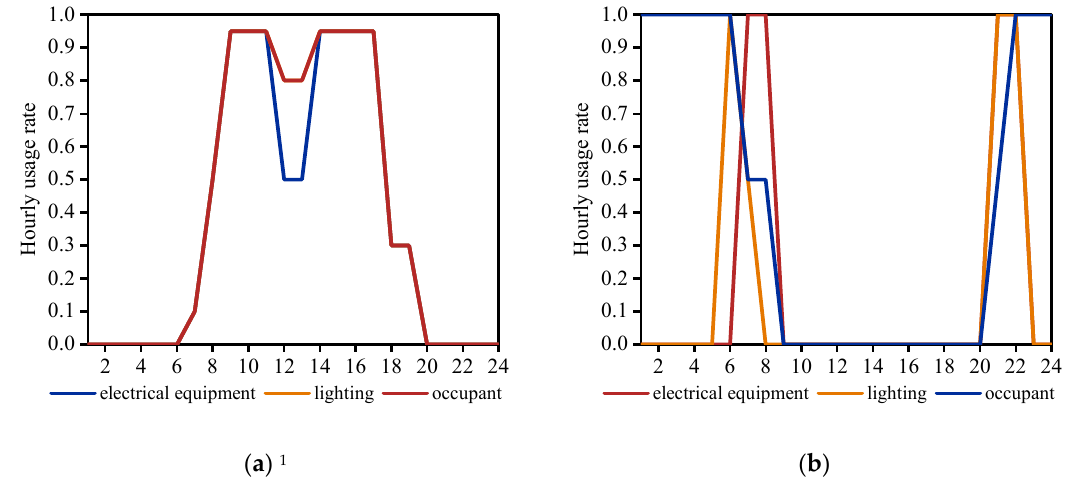
Figure 8. Overview of the building occupancy schedules: ( a ) office building; and ( b ) residential building. 1 “occupant” schedule curve coincides with the “lighting” of the office building.